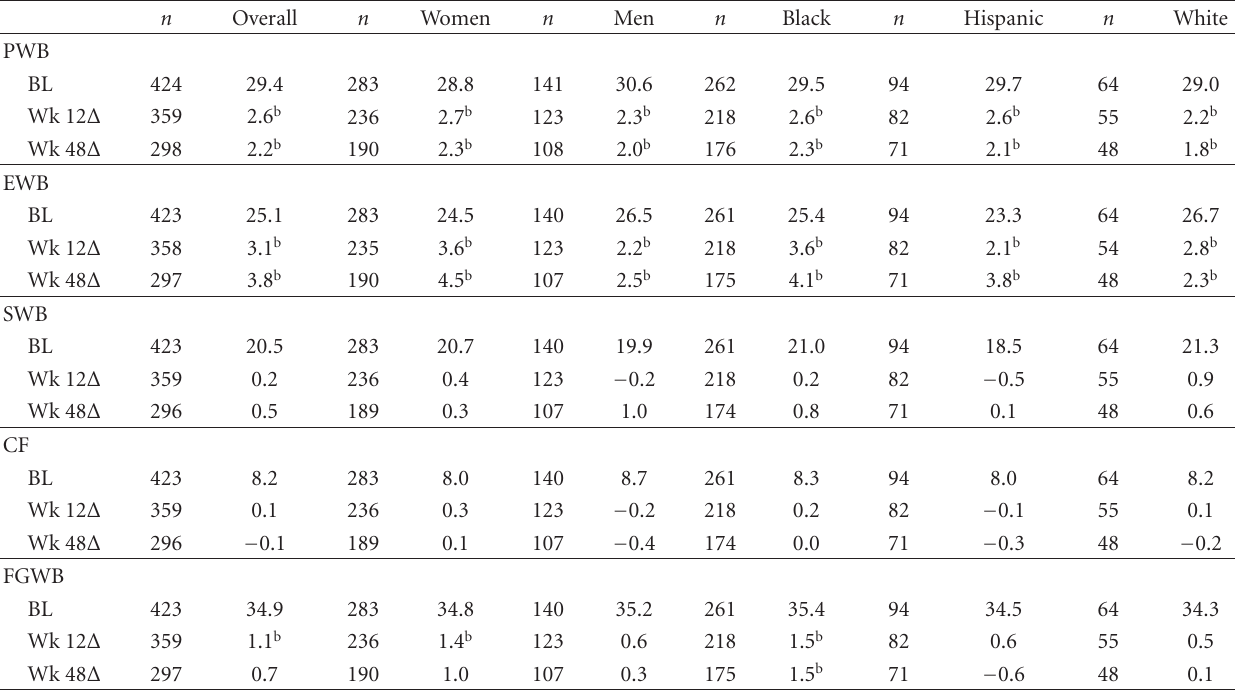
Table 4: Mean change from baseline in FAHI questionnaire subscales (observed a